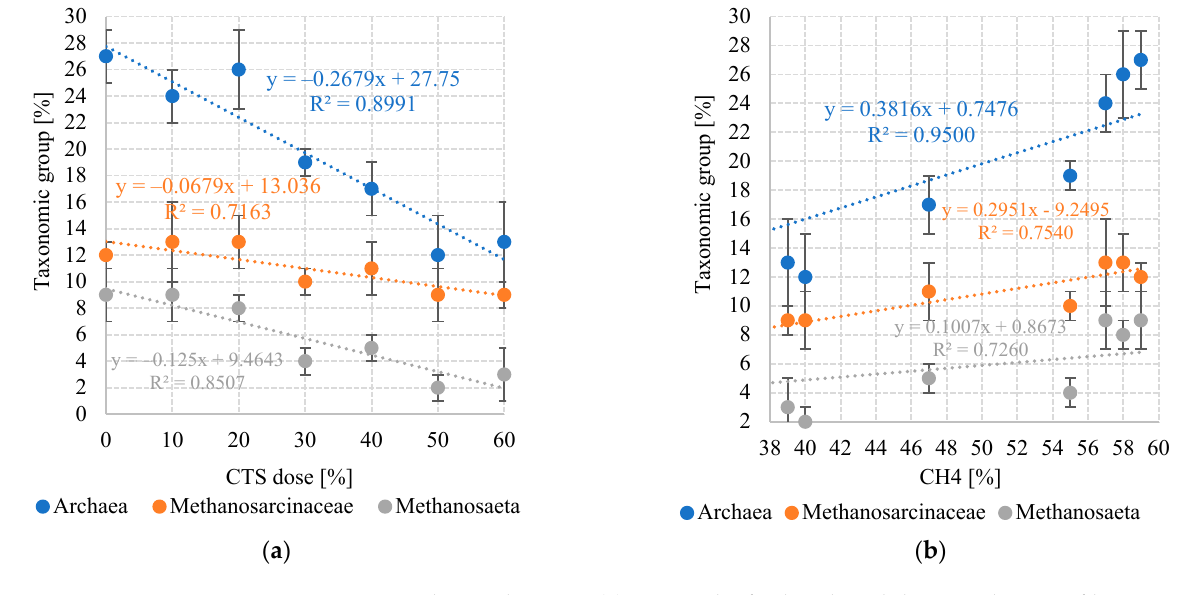
Figure 3. Correlations between ( a ) CTS in the feedstock and the contribution of basic taxonomic groups of methanogens, ( b ) the contribution of individual taxonomic groups of methanogens and CH 4 in the biogas.